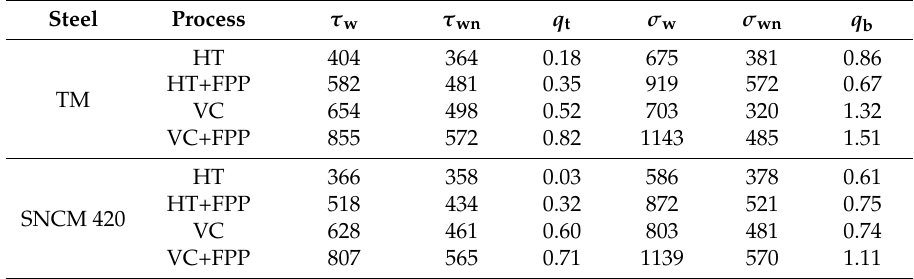
Table 5. Fatigue properties of TM and SNCM420 steels subjected to various processes.